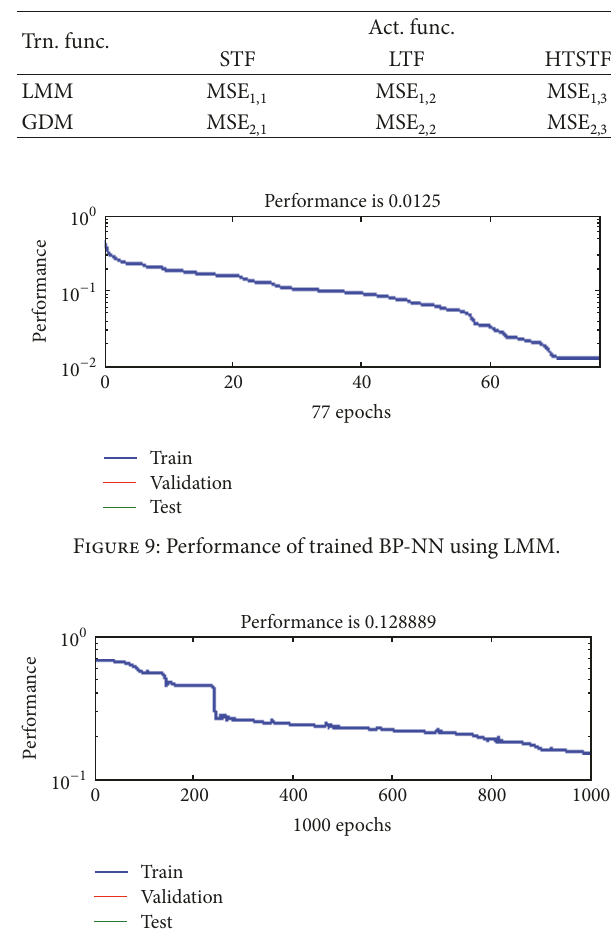
Figure 10: Performance of trained BP-NN using